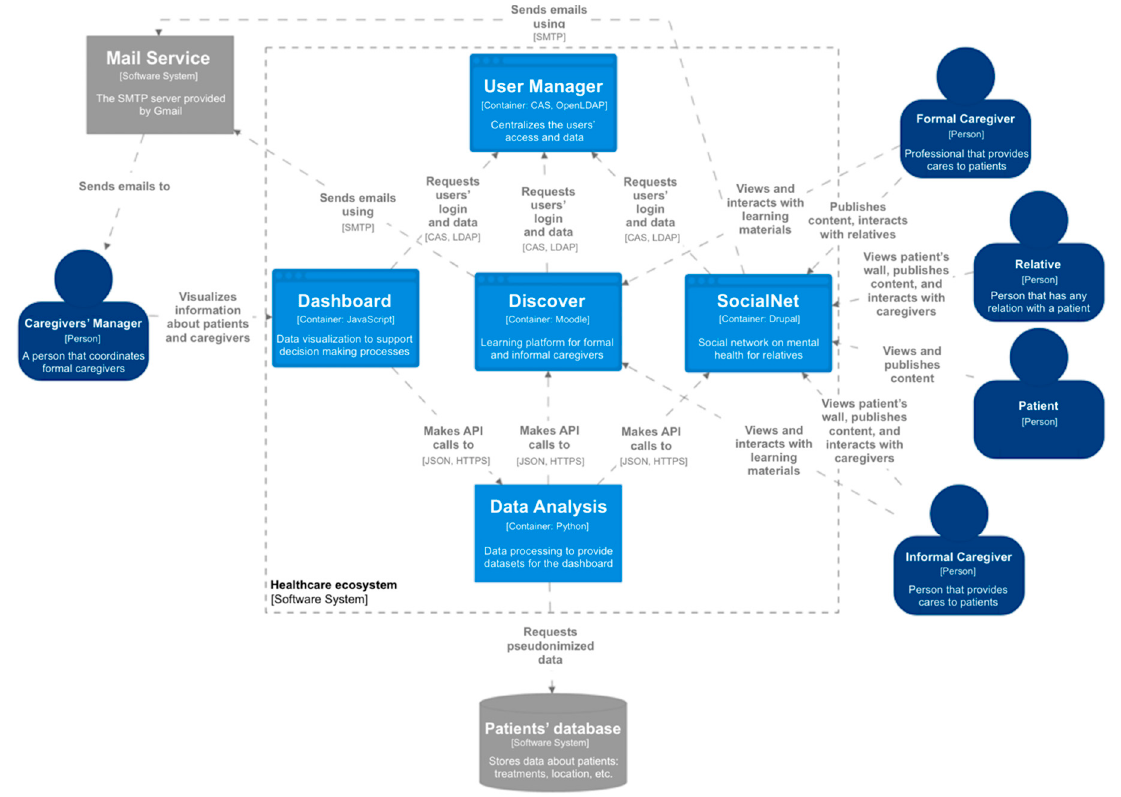
Figure 3. Healthcare ecosystem architecture in the C4 model. This diagram is also available on